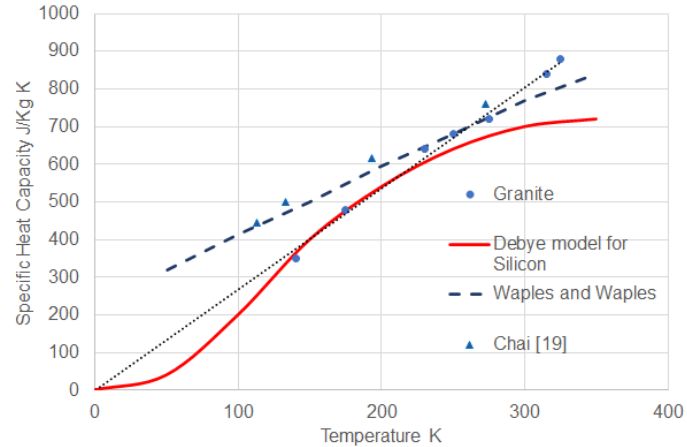
Figure 4. Relationship between specific heat capacity and temperature from the present work and published correlations. Adapted from [8] and